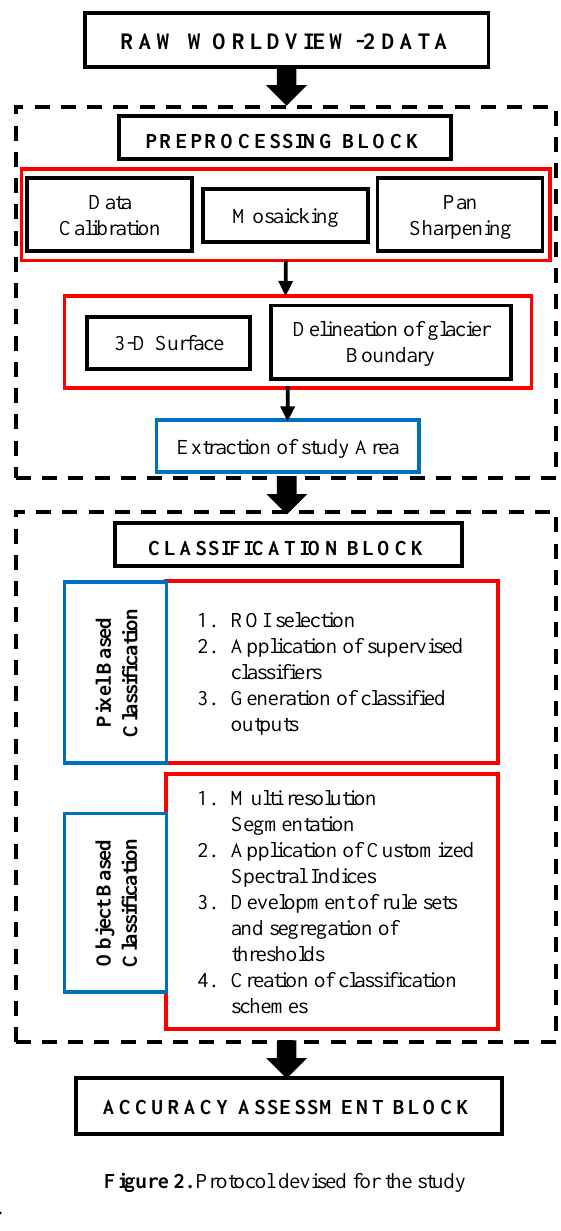
Figure 2. Protocol devised for the study .